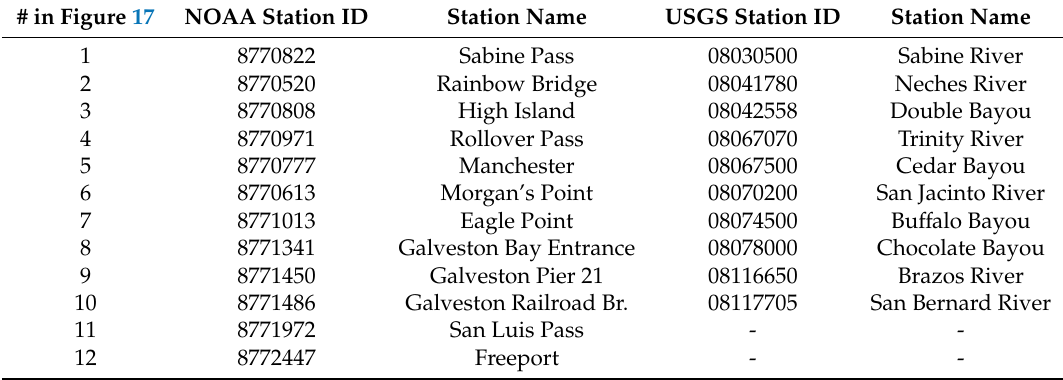
Figure 17. The model domain and the horizontal grid. The ten blue dots denote included river boundaries, and the twelve red squares show National Oceanic Atmospheric Administration (NOAA) tide stations; the numbers are the corresponding station numbers in Table 2. The upper panel is the zoom-in of the selected coastal area at the lower Galveston Bay. Table 2. NOAA tide stations and United States Geological Survey (USGS) river gaging stations used in the model